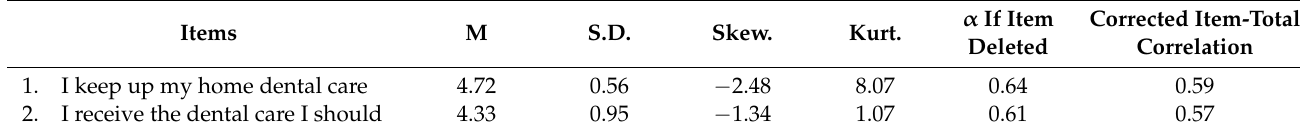
Table 1. Descriptive statistics of all items of the DNS-RO (N =